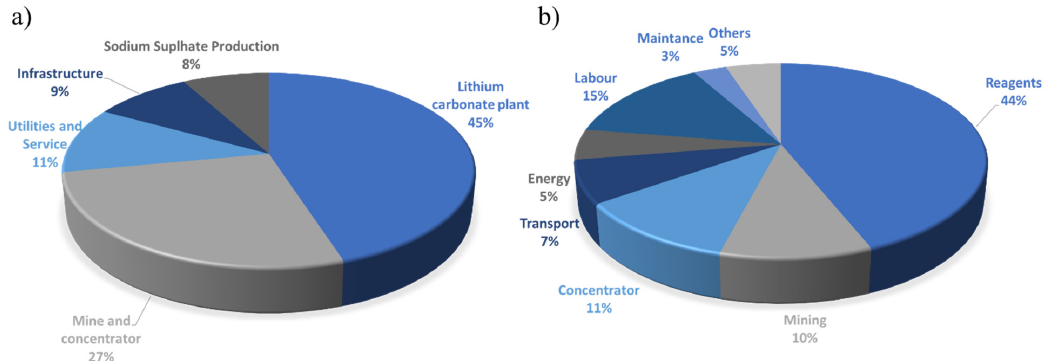
Figure 6. The distribution of shares of the individual components for lithium recovery from minerals ( a ) and brines ( b ). [121]. ( a ) and brines ( b )